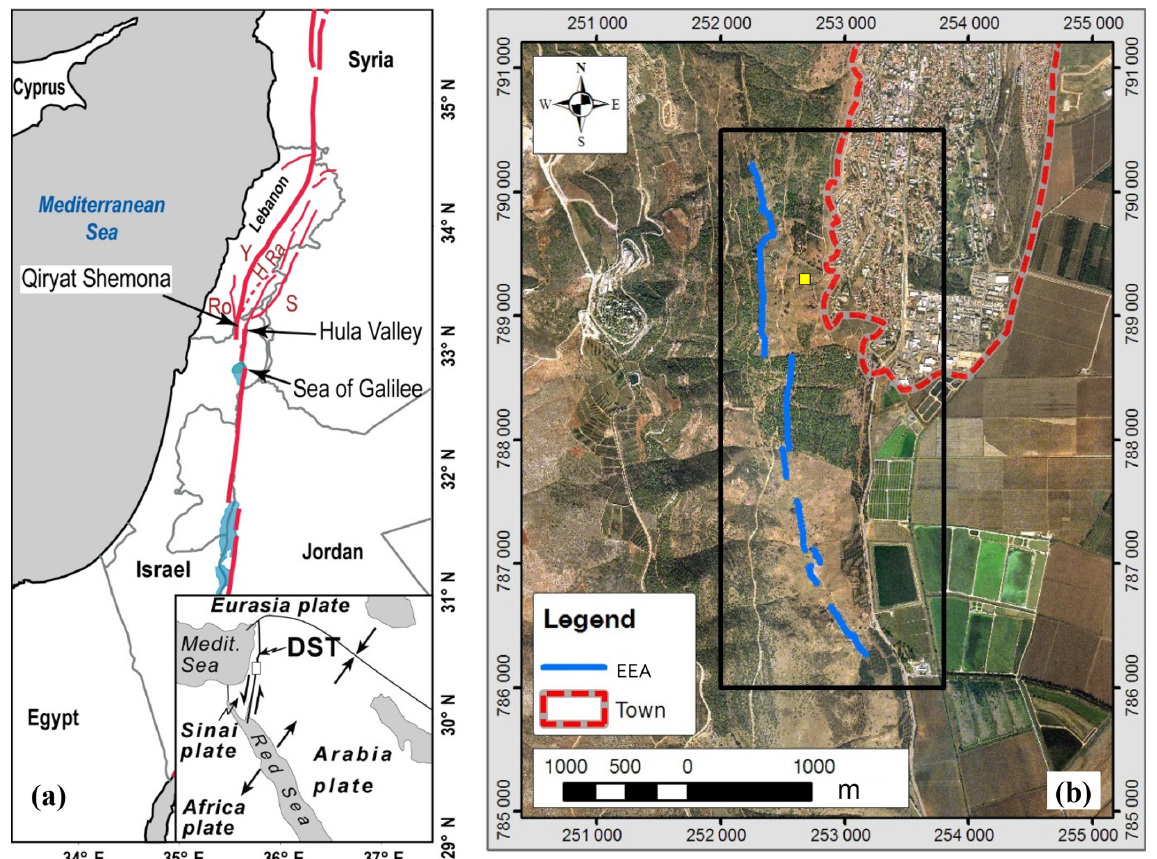
Figure 1. (a) Location map of the study area detailing the major fault segments of the DST (Ro: Roum; Y: Yammuneh; H: Hatsbaya; Ra: Rashaya; S: Serghaya). Inset shows the plate tectonic setting of the DST. (b) Orthophoto map of the study area (black rectangle). The rockfall source, the Ein El Assad Formation (EEA), is marked by a blue line and the town border by a red dashed line. The yellow rectangle marks the location of block 016 shown in Fig.